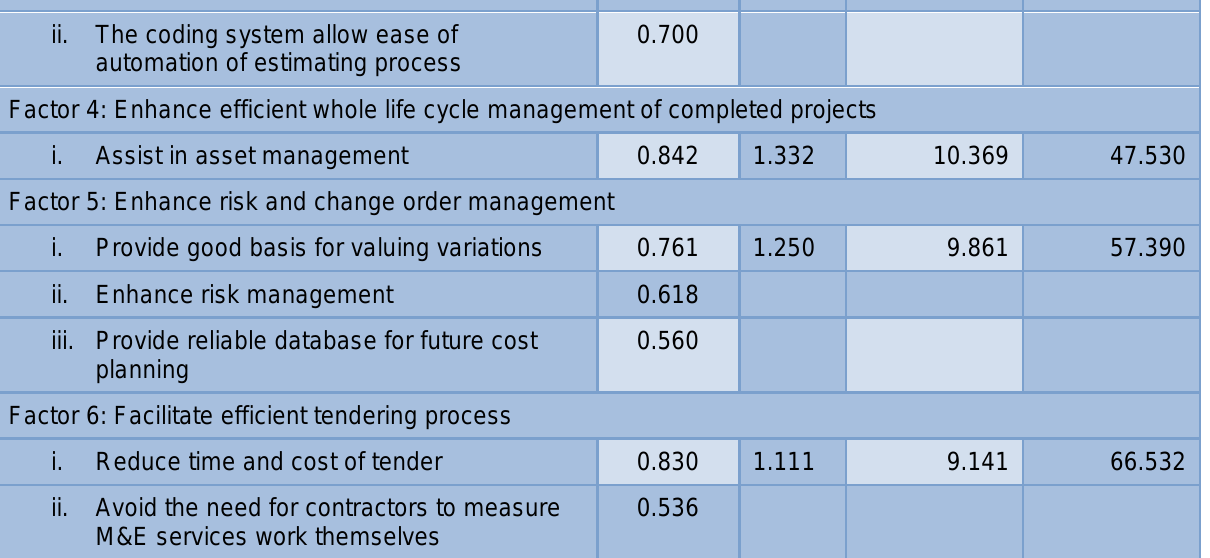
Table 3 Principal factor extraction and Varimax Rotation of 14 Benefits of SBPM Factor 4: Enhance efficient whole life cycle cost